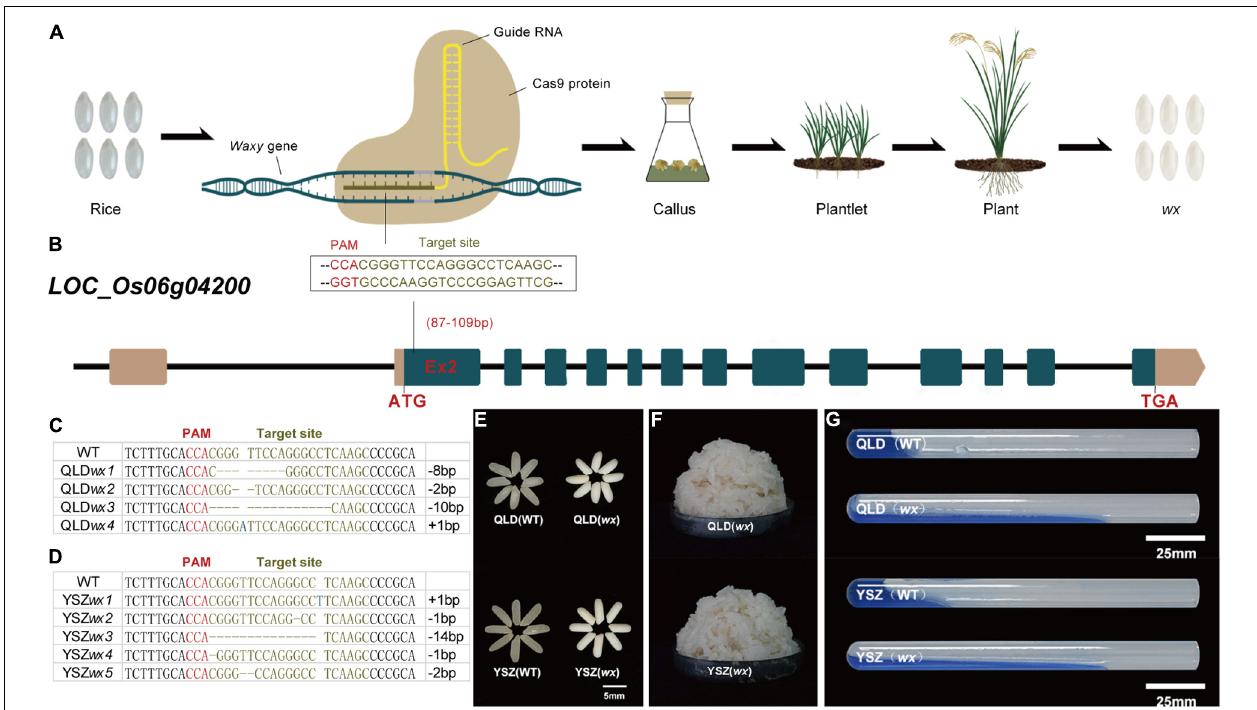
FIGURE 1 | New waxy rice by CRISPR/Cas9-mediated mutagenesis of Waxy gene in two rice varieties. (A) Schematic experimental design. From left to right are wild-type rice, CRISPR/Cas9 system, callus, plantlet, plant, and waxy rice. (B) Schematic diagram of the targeted site in exon 2 of Waxy gene ( LOC_Os06g04200 ). The numbers in brackets indicate the distance to the start codon (ATG). (C–D) Nucleotide variations at the targets (the protospacer adjacent motif in blank) of homozygous mutant lines from YSZ wx1 and QLD wx4. “ − ”, base deletion; “+”, base insertion. The targeted sequence is highlighted in brown, and the protospacer adjacent motif (PAM) sequences are in red. (E) Grain phenotypes of wx mutants and their corresponding WTs. (F) The appearance of cooked waxy rice. (G) Gel consistency.